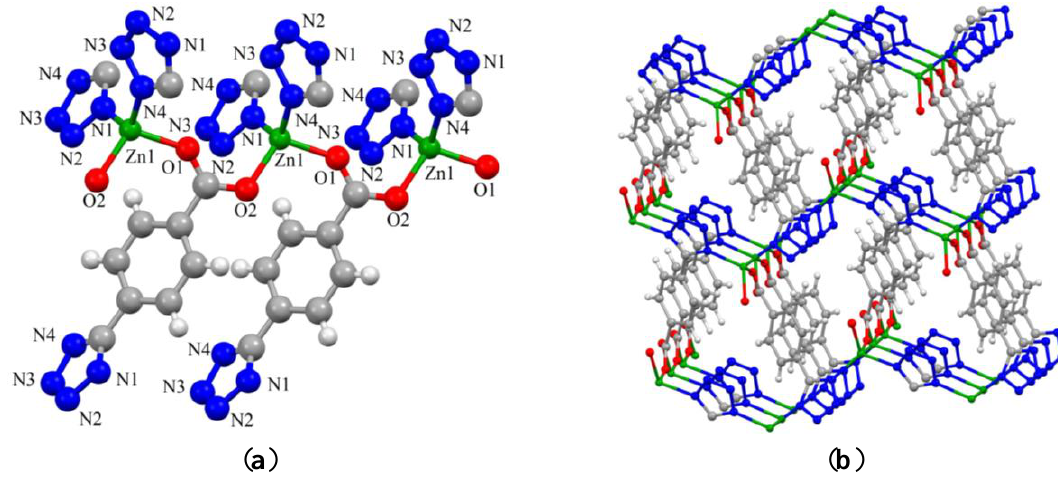
Figure 3. ( a ) The coordination environment of the zinc ions in compound 2 .